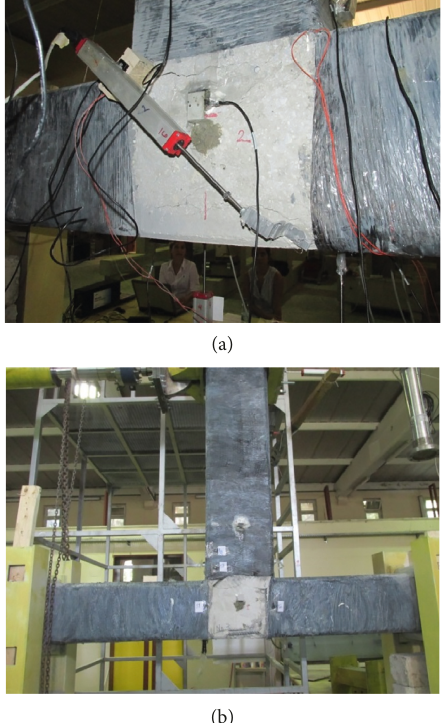
Figure 13: Failure of Sample 3.